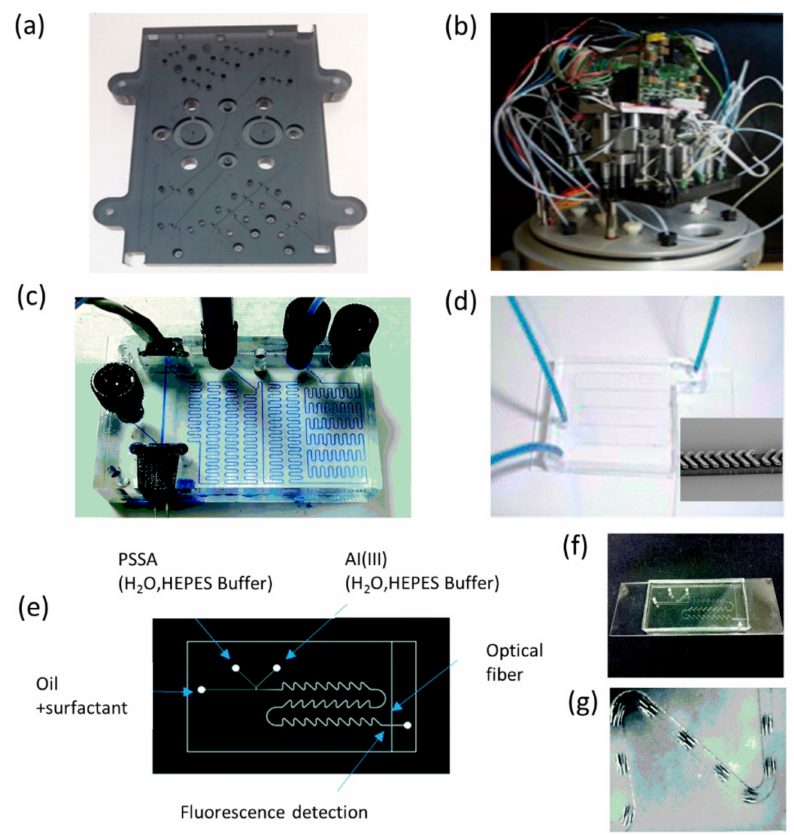
Figure 7. Spectrophotometric and fluorescent detection of heavy metal by optofluidic systems. ( a , b ) The photograph and the autonomous integrated device of the microanalyzers used to determine dissolved Fe and Mn with a spectrophotometric method. ( c ) The PMMA optofluidic chip used for arsenic detection with a colorimetric method. ( d ) The photograph of the optofluidic chip for fluorimetric detection of cadmium. ( e ) The scheme of the optofluidic set-up following the droplets approach for fluorescent detection of water-soluble aluminium. ( f , g ) The photographs of the microchip and the forming droplet of the fluorescent sensor. Images reproduced from